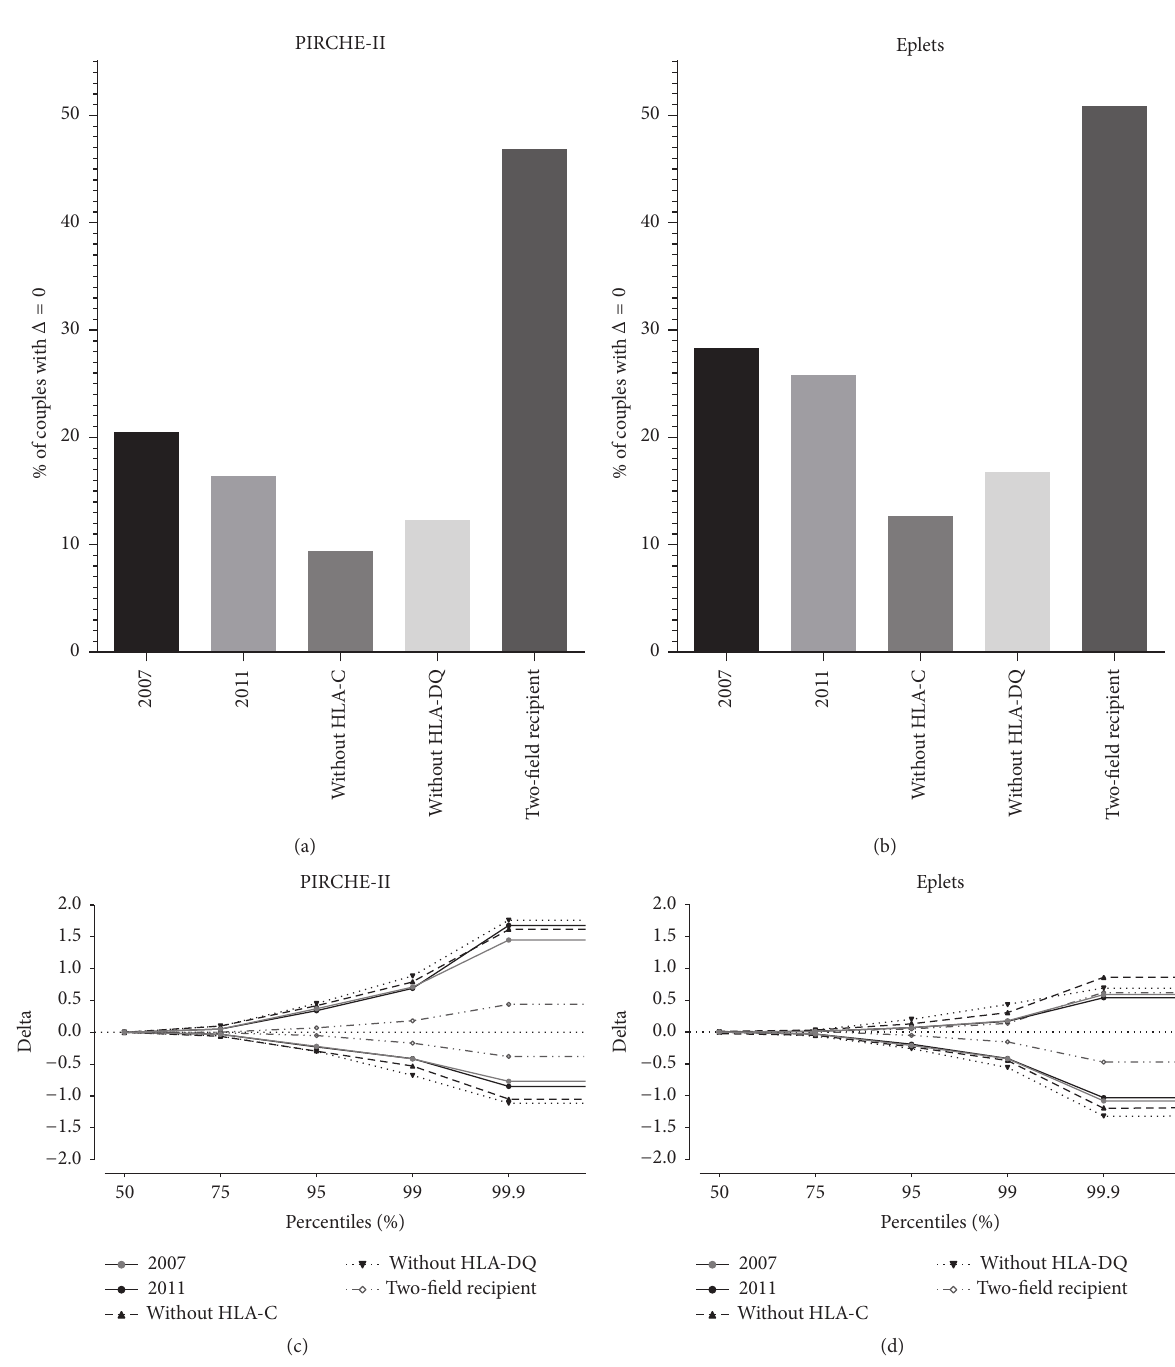
Figure 3: The reliability of the PIRCHE-II and eplet estimations in different settings. The percentage of typing with a delta of zero between the observed and the reference values was plotted for ln(PIRCHE-II) (a) and ln(eplet) (b). For both ln(PIRCHE-II) and ln(eplet) , the percentage of typing with a delta of zero was diminished when HLA-C or HLA-DQ was omitted from the typing. The highest percentage was observed when using two-field HLA genotype data of the recipient and serological split level typing of the donor. The different percentiles observed in the different settings were plotted for ln(PIRCHE-II) (c) and for ln(eplet) (d). The dashed horizontal lines in (c) and (d) indicate a delta of